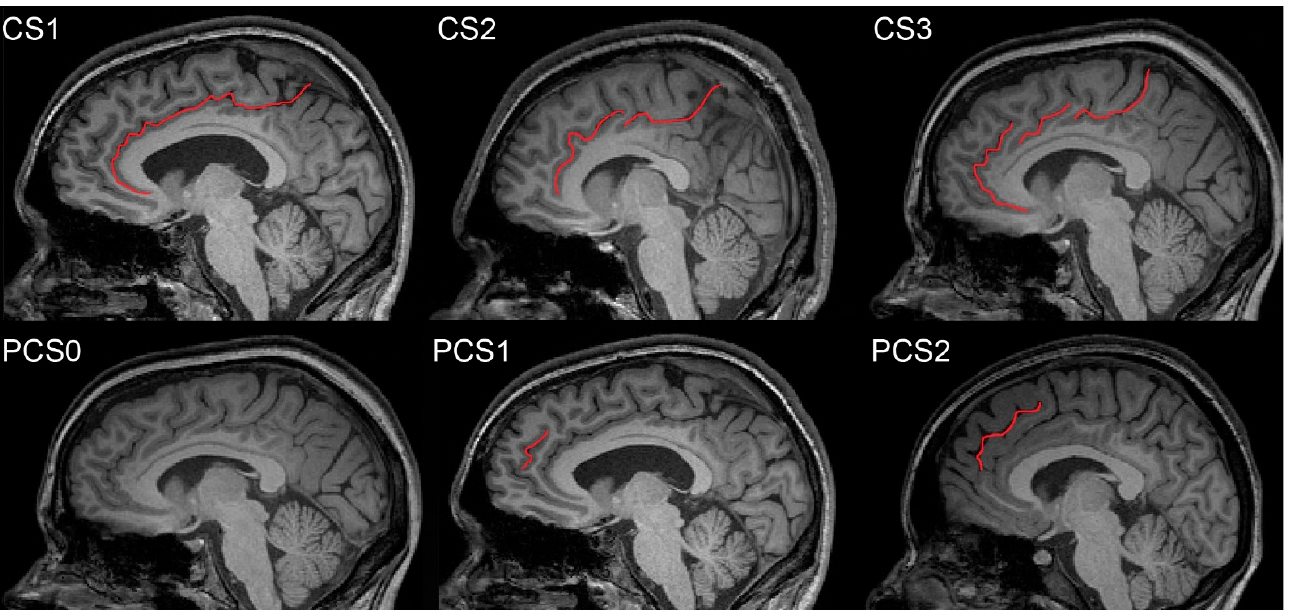
Figure 1. Illustrative examples of possible appearances of CS and PCS morphology types on the MRI images.